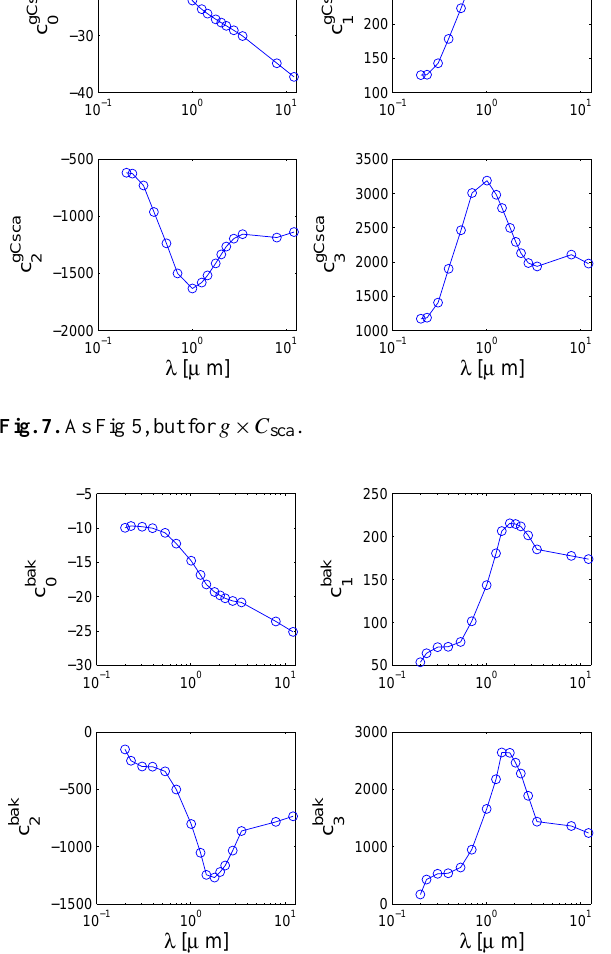
Fig. 8. As Fig 5, but for C bak .